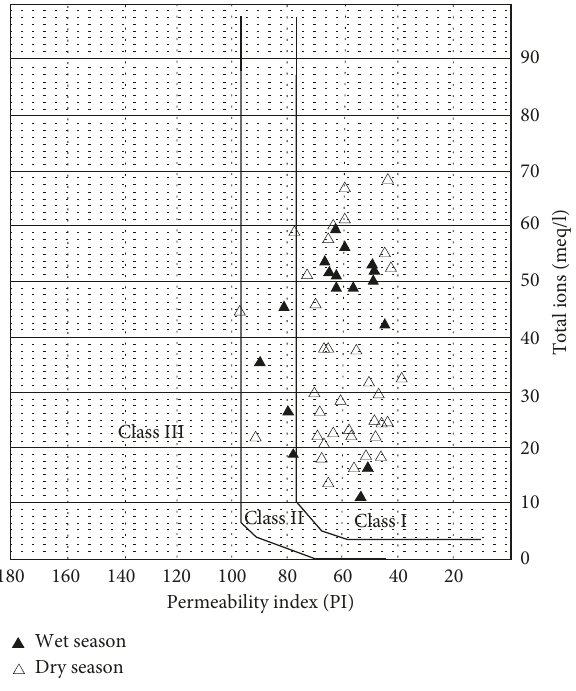
Figure 19: A Doneen’s chart for the study